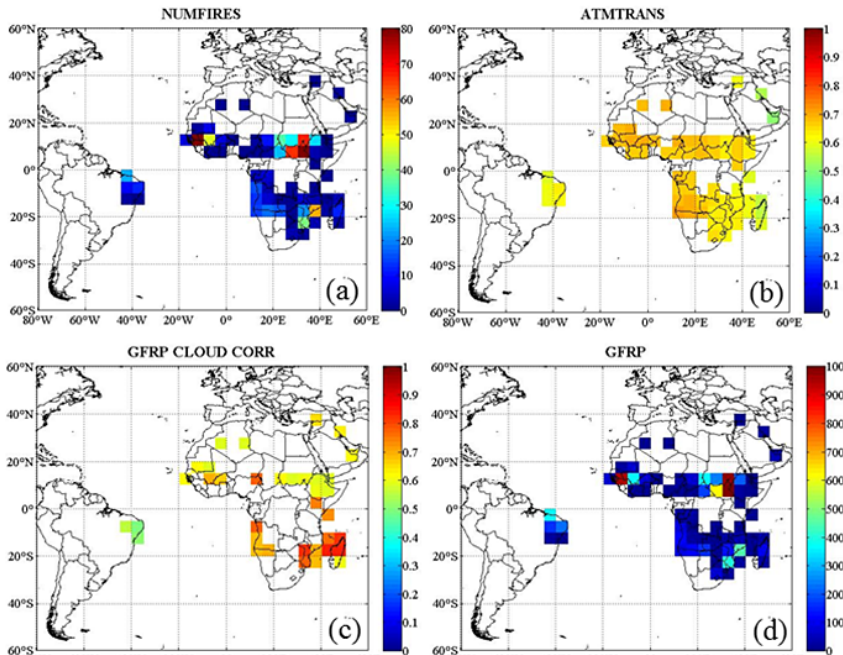
Figure 16. Example of the product contents for a single FRP-GRID product (issued hourly), as recorded on 11 November 2009 at 14:00UTC, including (a) the average number of fires detected per 15min imaging time slot, (b) the average atmospheric correction factor, (c) the average cloud correction factor, and (d) an estimate of the average FRP that MODIS would have measured during the hour. A full description of all FRP-GRID product fields is provided in Table